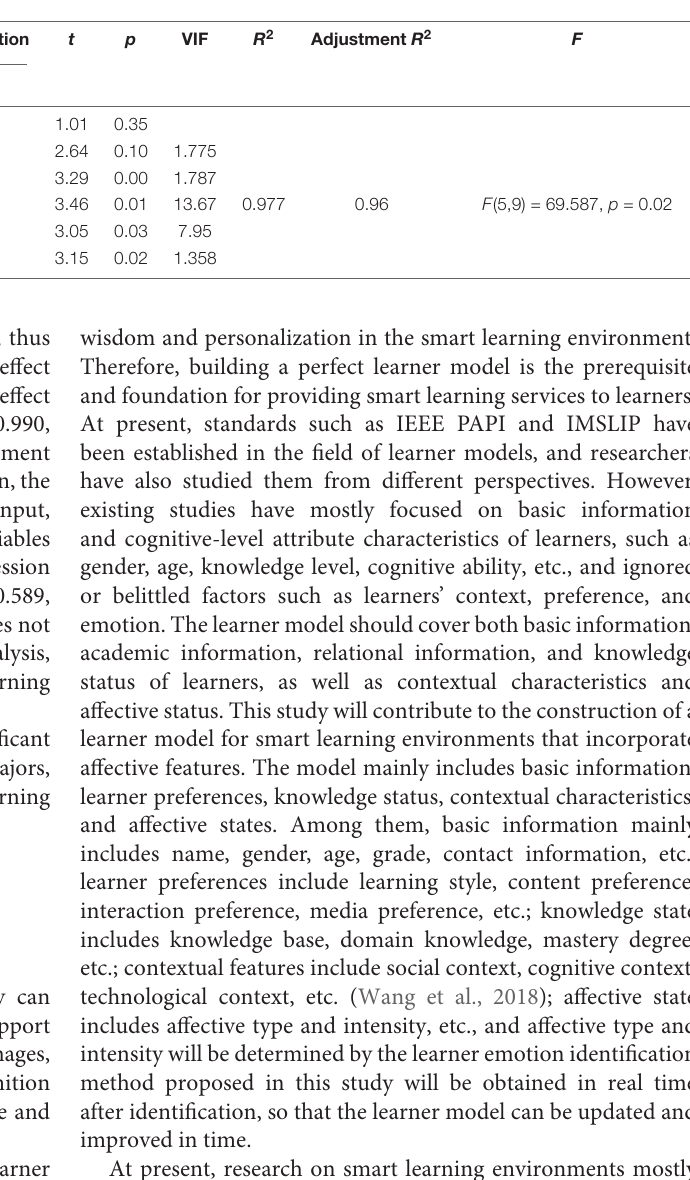
TABLE 4 | Results of specific factors affecting in English